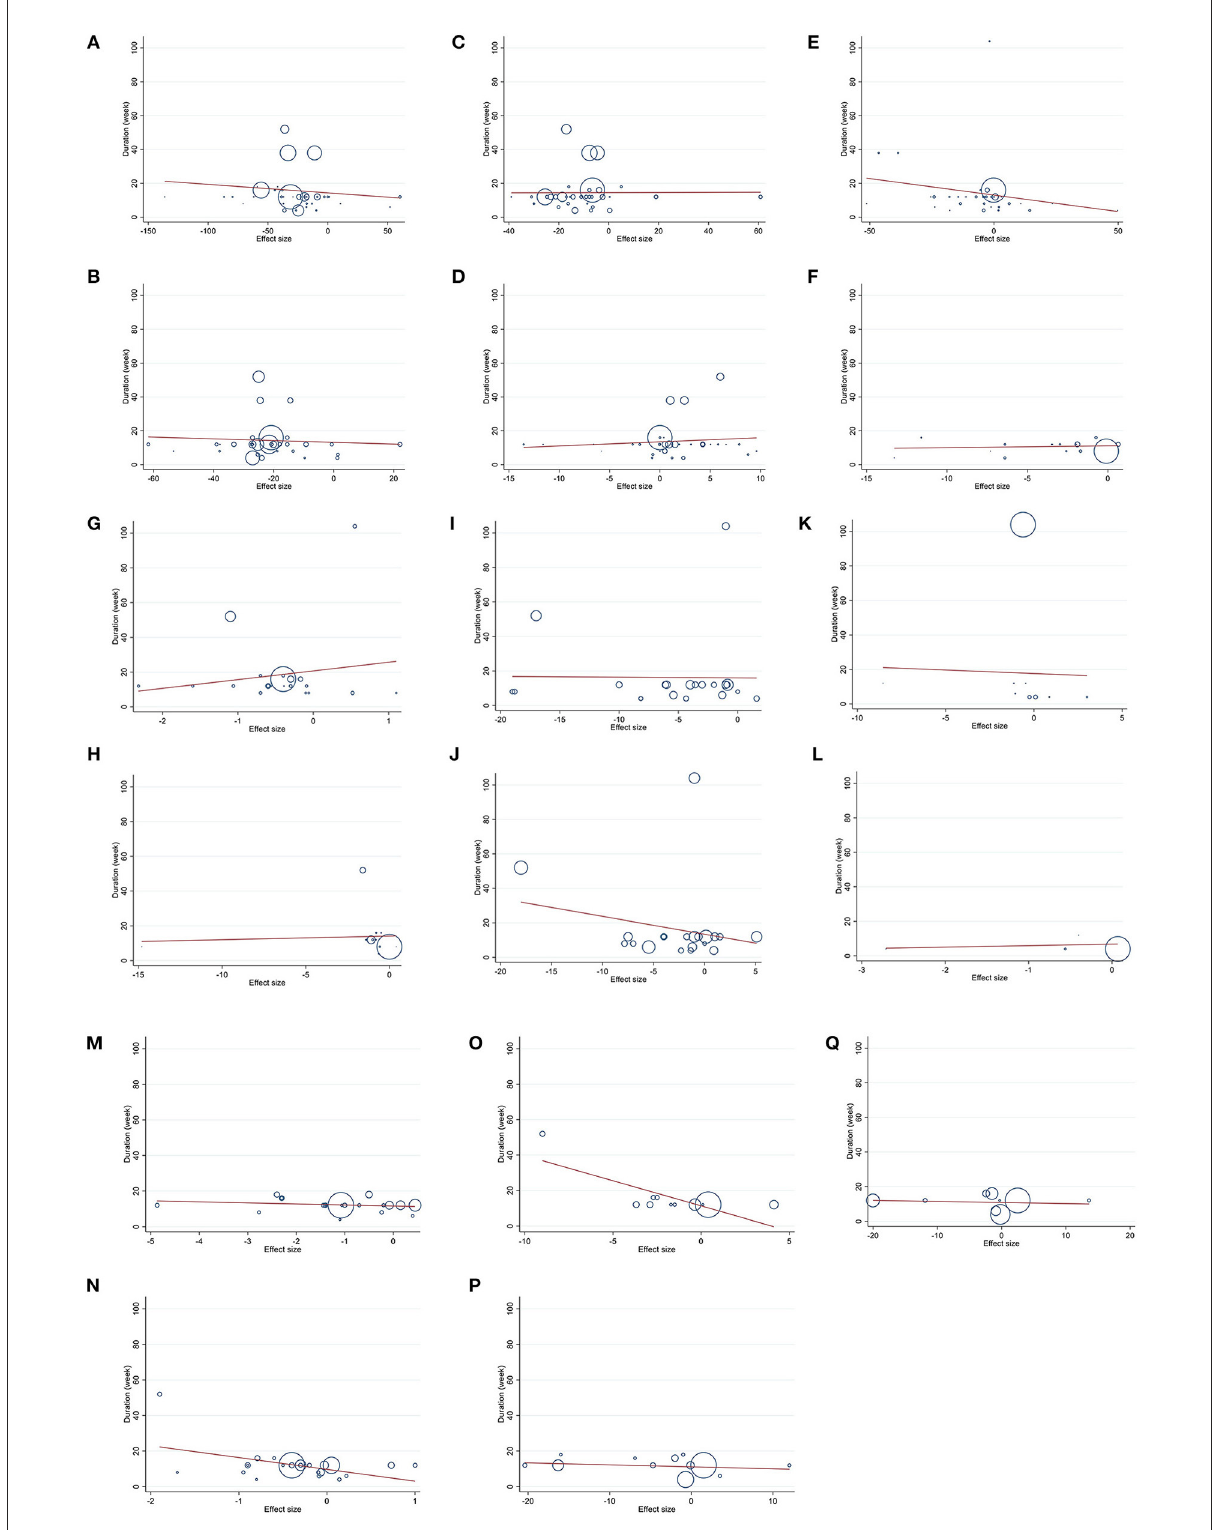
FIGURE5 Linear dose-response relations between berberine consumption and absolute mean differences. Dose-response relations between duration of intervention (week) and absolute mean differences in (A) TG (mg/dl); (B) TC (mg/dl); (C) LDL (mg/dl); (D) HDL (mg/dl); (E) FBG (mg/dl); (F)